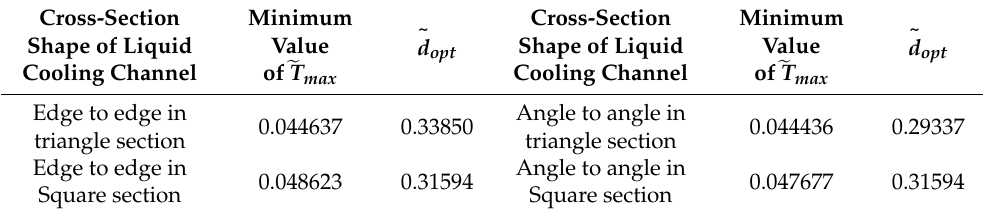
Table 1. The relationship between the minimum value of (cid:101) T max and (cid:101) d in four models.